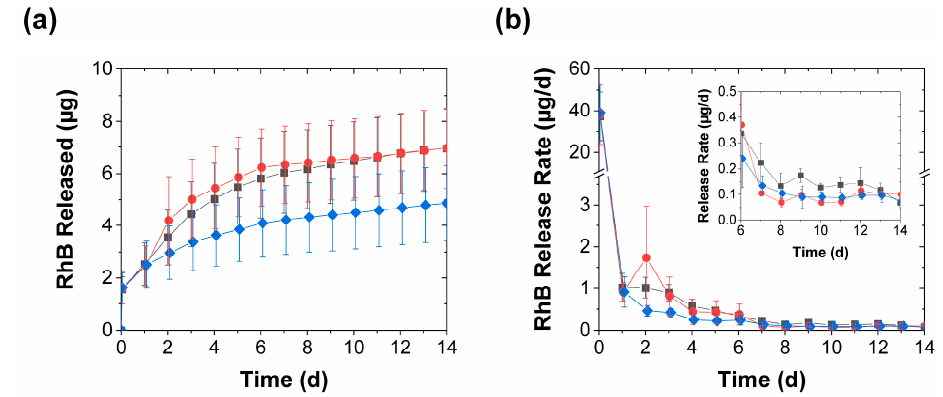
Figure 7. RhB release from coacervates into 1× PBS achieved with ( ■ ) daily perforation with five needle jabs, ( • ) daily compression, and ( (cid:7) ) without mechanical stimulation and shown in terms of both ( a ) the total RhB mass released and ( b ) the release rate (mean ± SD). The inset provides a closeup of the slower release rates near the end of the experiment, while the lines are guides to the eye.